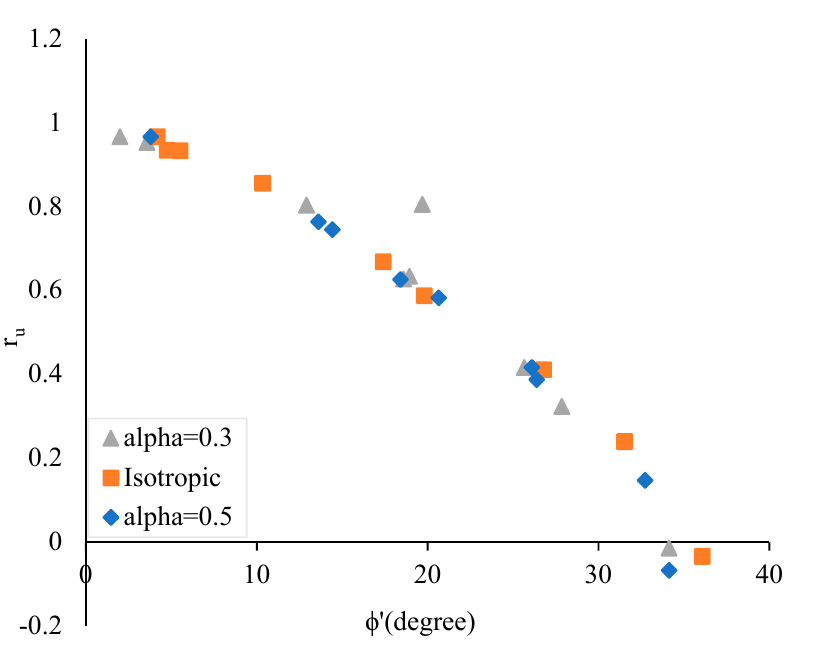
Figure 14. Pore water pressure ratio versus friction angle at failure in isotropic and anisotropic stress.